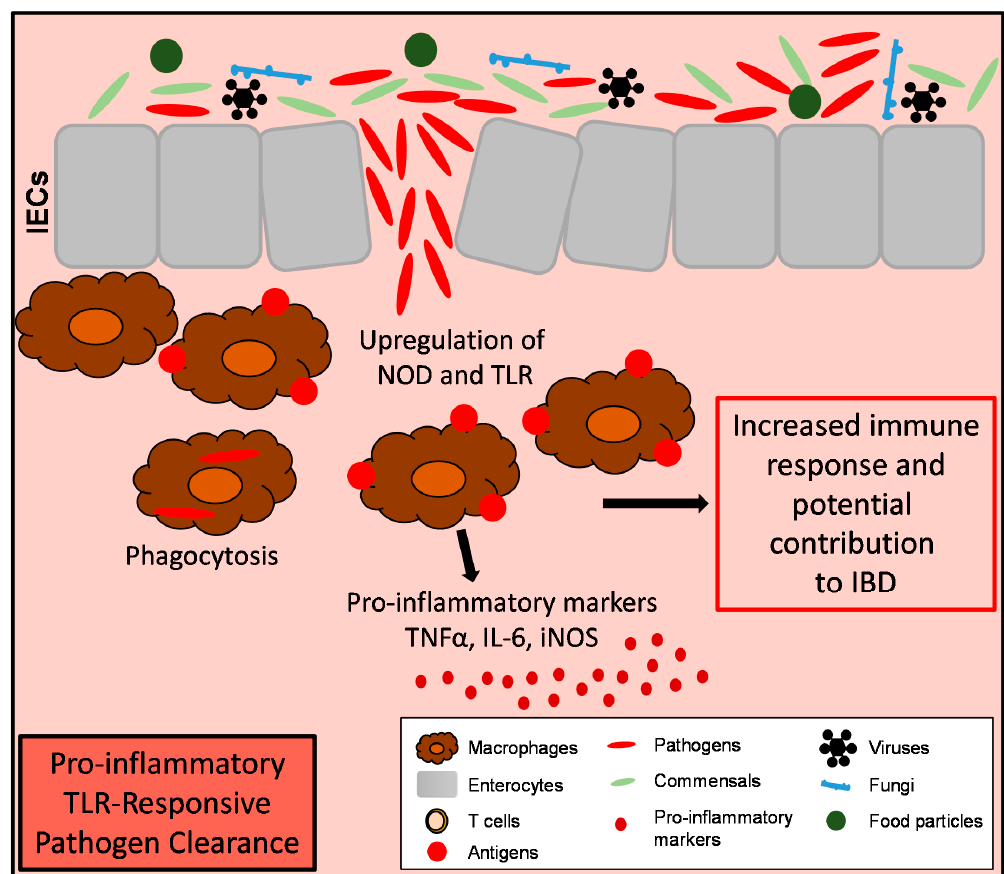
Figure 3. Macrophages in intestinal inflammation. Increased numbers of macrophages are present